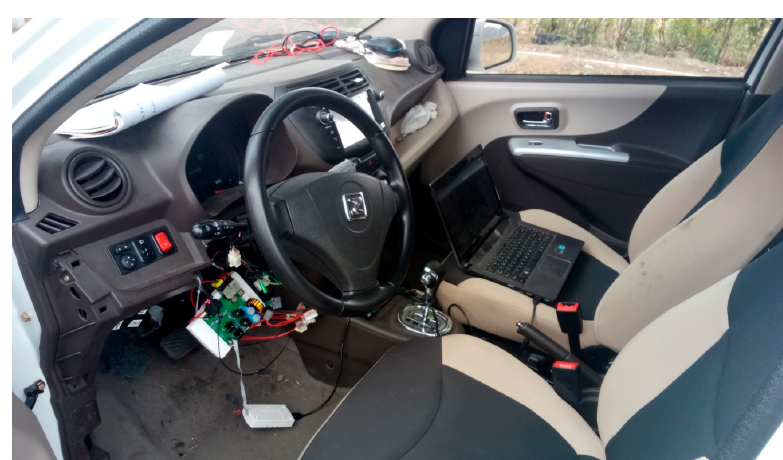
Figure 8. Experimental vehicle.